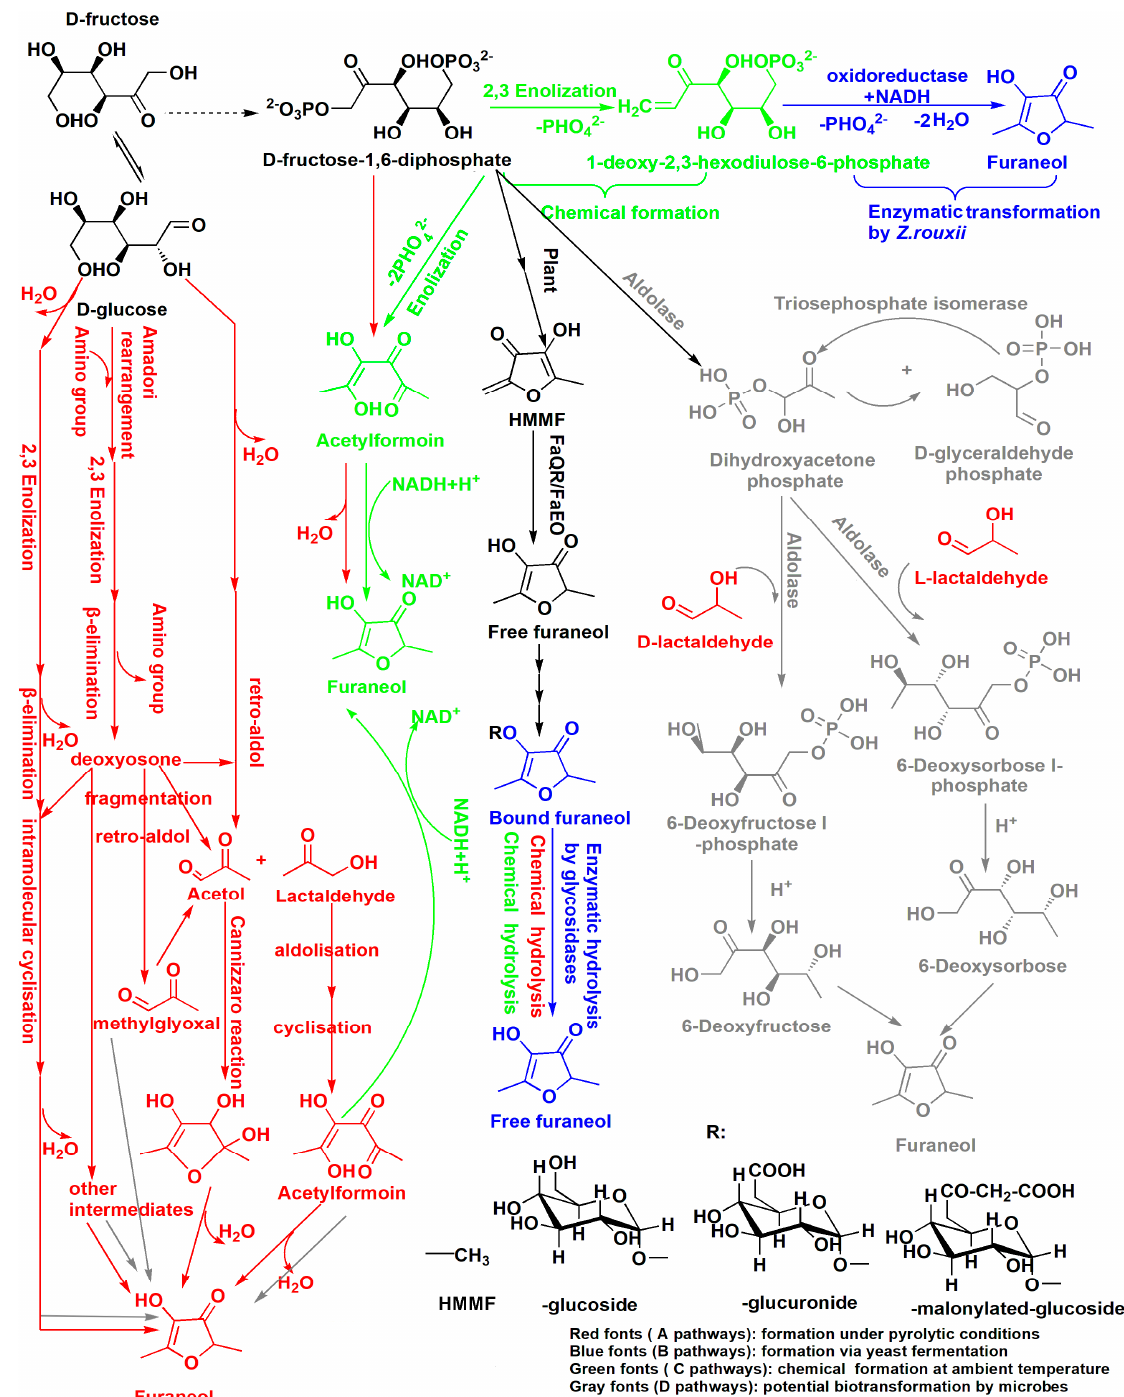
Figure 3. Multiple pathways of furaneol formation during Msalais wine making. FaQR: Fragaria × ananassa quinone oxidoreductase, FaEO: F. × ananassa enone oxidoreductase, HMMF: 4-hydroxy-5-methyl-3(2 H )-furanone. The pathways were reported by Nashalian et al. [26], Dahlen et al. [27], Hauck et al. [25,37], Schieberle et al. [38], Wang et al. [39], Wong et al. [40], and Zabetakis et al. [40] .